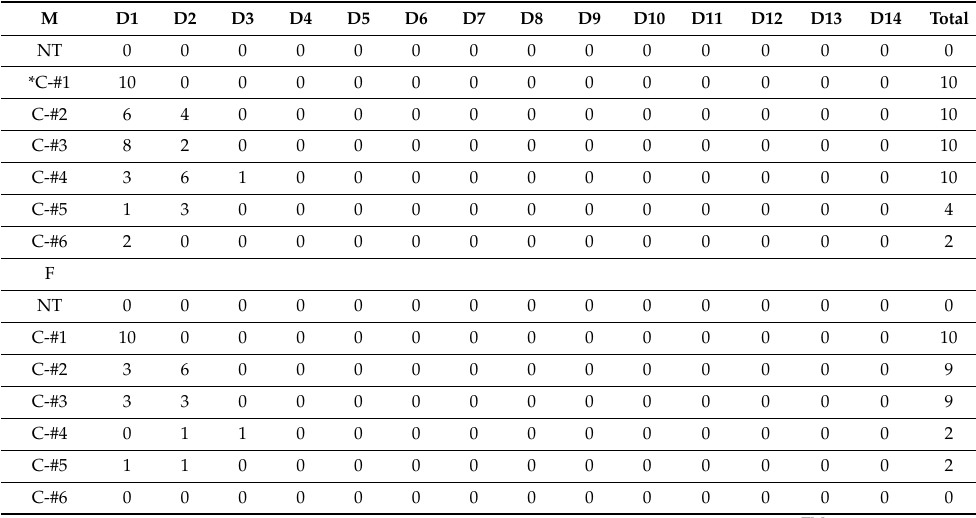
Table 3. Number of dead animals following high concentrations of single ClO 2 gas